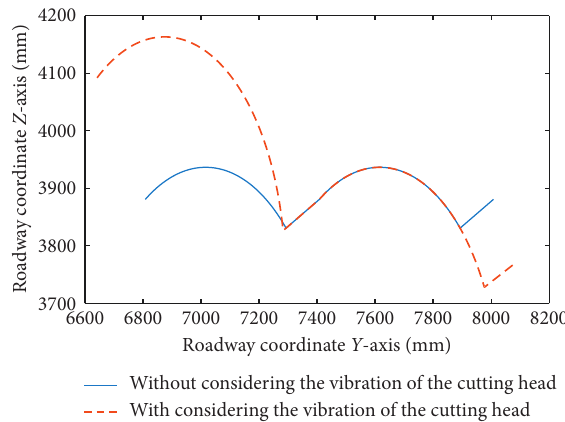
Figure 9: Simulation results of roadway surface morphology.